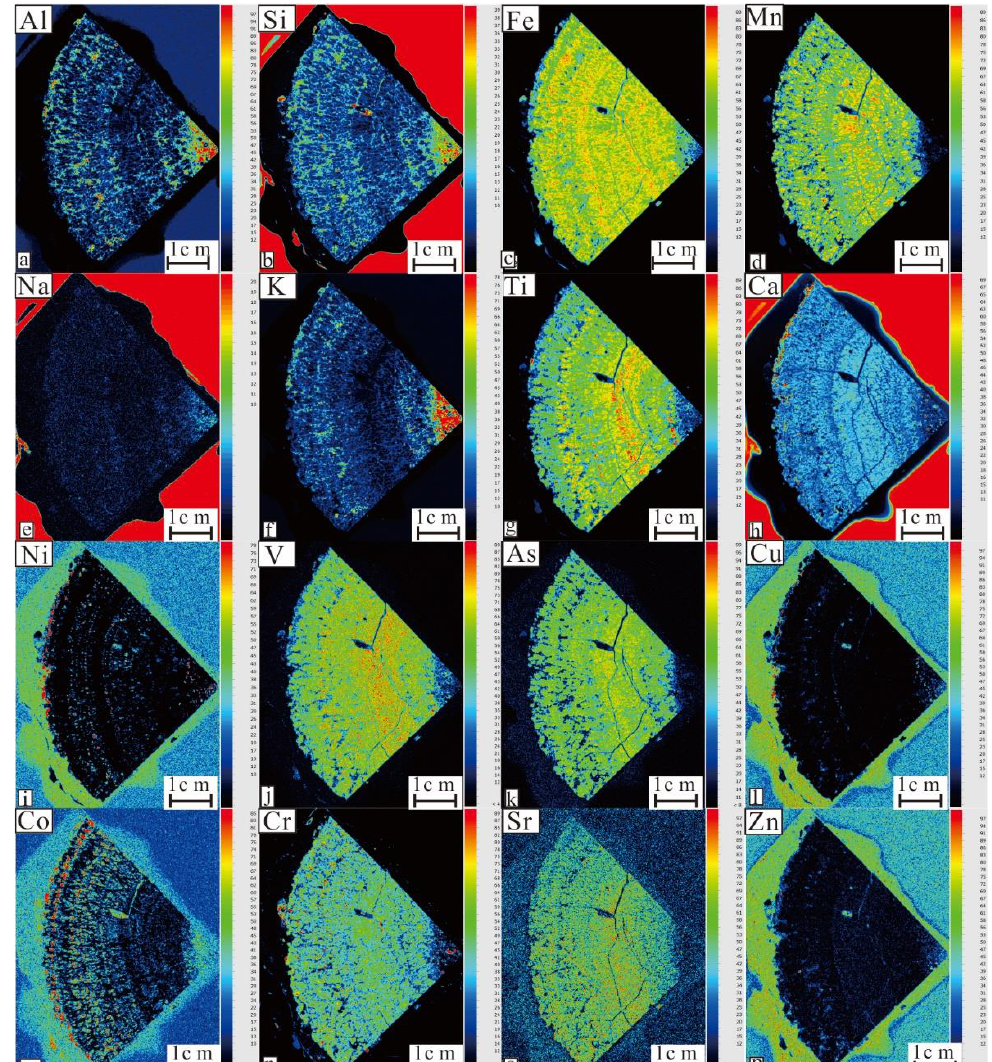
Figure 6. XRF scan results of multi-elements in the polymetallic nodule profile. ( a ) Al element scan result; ( b ) Si element scan result; ( c ) Fe element scan result; ( d ) Mn element scan result; ( e ) Na element scan result; ( f ) K element scan result; ( g ) Ti element scan result; ( h ) Ca element scan result; ( i ) Ni ele- ment scan result; ( j ) V element scan result; ( k ) As element scan result; ( l ) Cu element scan result; ( m ) Co element scan result; ( n ) Cr element scan result; ( o ) Sr element scan result; ( p ) Zn element scan result; (The red indicates the most element content and blue indicates the least element content).